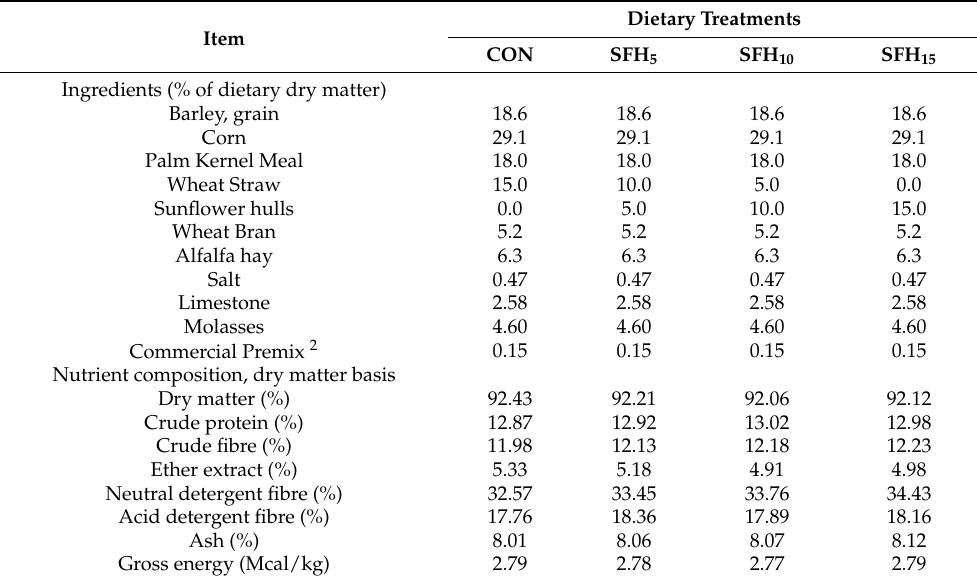
Table 1. Ingredients and chemical composition of the experimental diets 1 . Dietary Treatments Item CON SFH 5 SFH